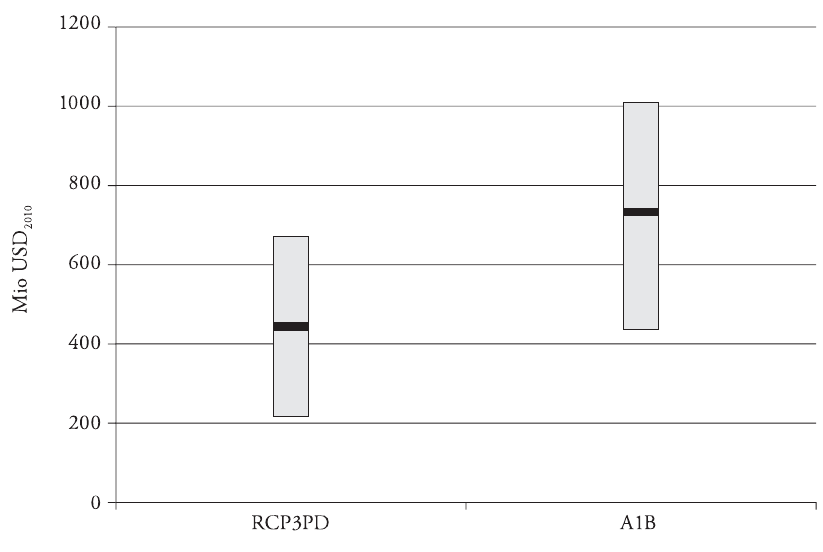
Figure 5: Welfare Change in 2060 Relative to the BAU Scenuio for Qualitative 95% Confidence Intervals of the RCP3PD and AlB Scenarios, in Mio USD